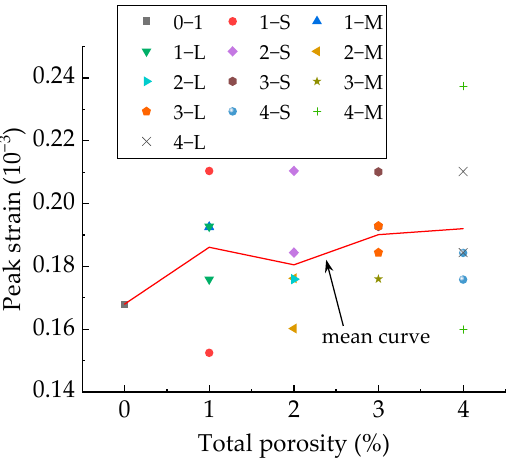
Figure 24. Relationship between the total porosity and the peak strain.